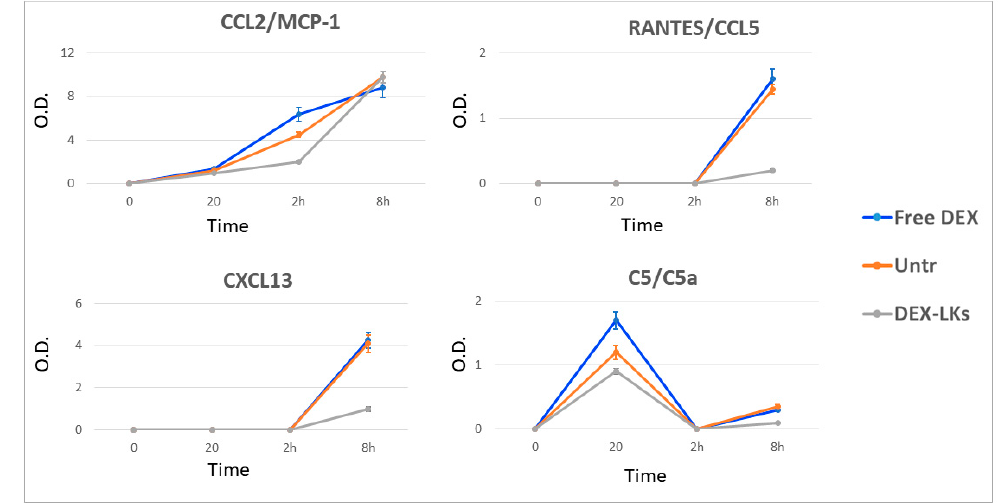
Figure 5. Levels of chemokines and complement proteins following treatment. The average net optical intensities (O.D.) for each chemokine are shown for each group at different time points. The basal levels of plasma cytokines of non-treated mice were evaluated by the same array and used to normalize the data. Results are presented as mean ± SD (n = 4).